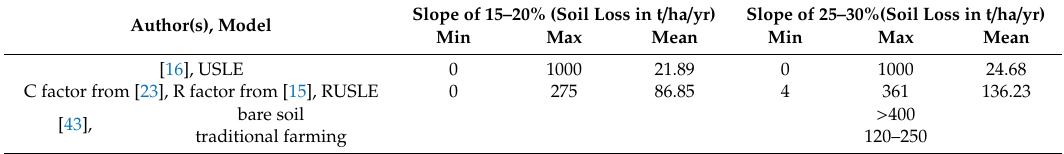
Table 8. (R)USLE results for cropland at a slope of 15–20% and 25–30% in comparison to field work on a slope of